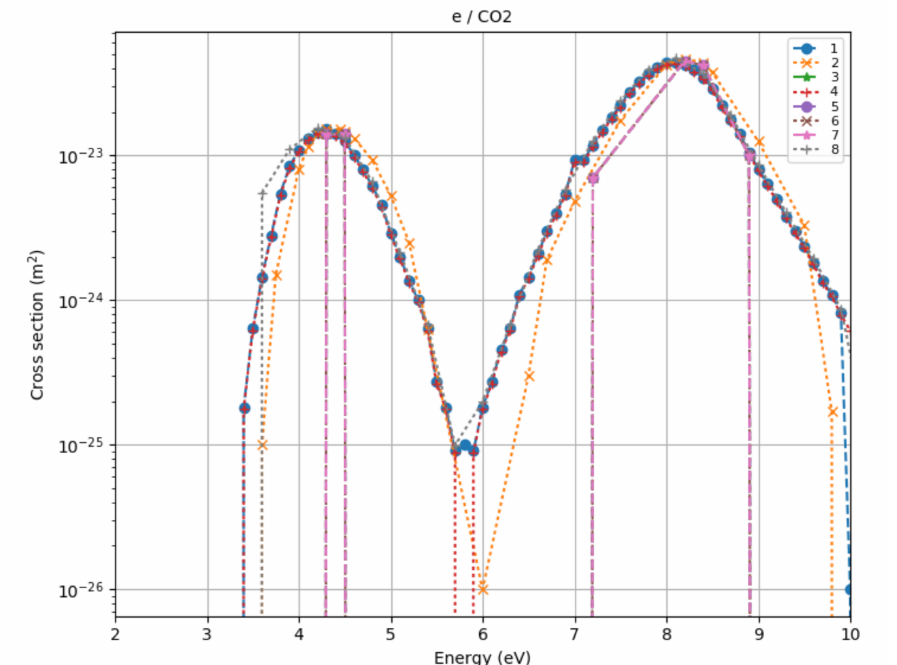
Figure 9. Comparison of the different electron attachment cross-sections with CO on LXCat: (1) Biagi [80], (2) Hayashi [100], (3) IST-Lisbon [35], (4) Itikawa [108], (5) Morgan [110], (6) Phelps [112], (7) SIGLO [116] and (8) TRINITI [117]